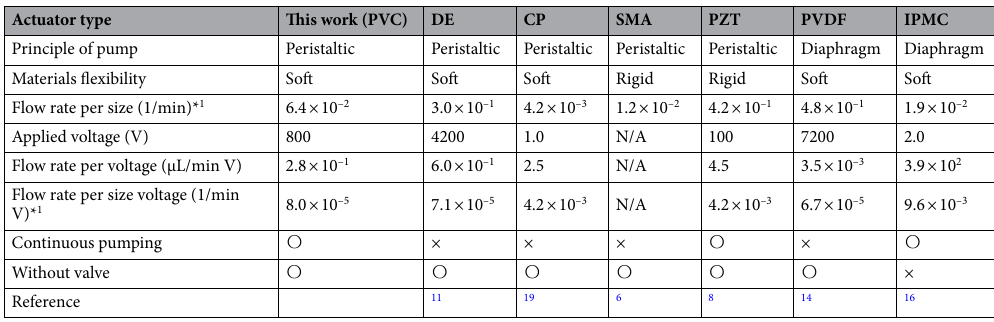
Table 1. Comparison of the pumping performance of the PVC gel pump developed in this study and pumps based on other smart materials. * 1 Volume is estimated from each